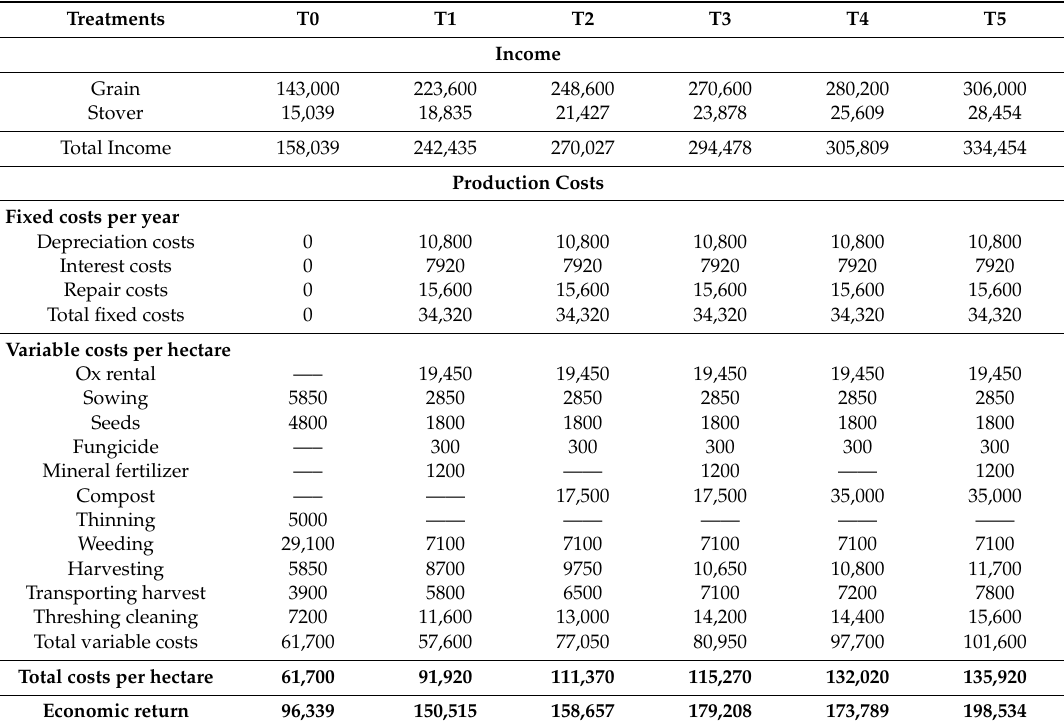
E ff ects of the treatments on income, production costs and economic return in the on-station